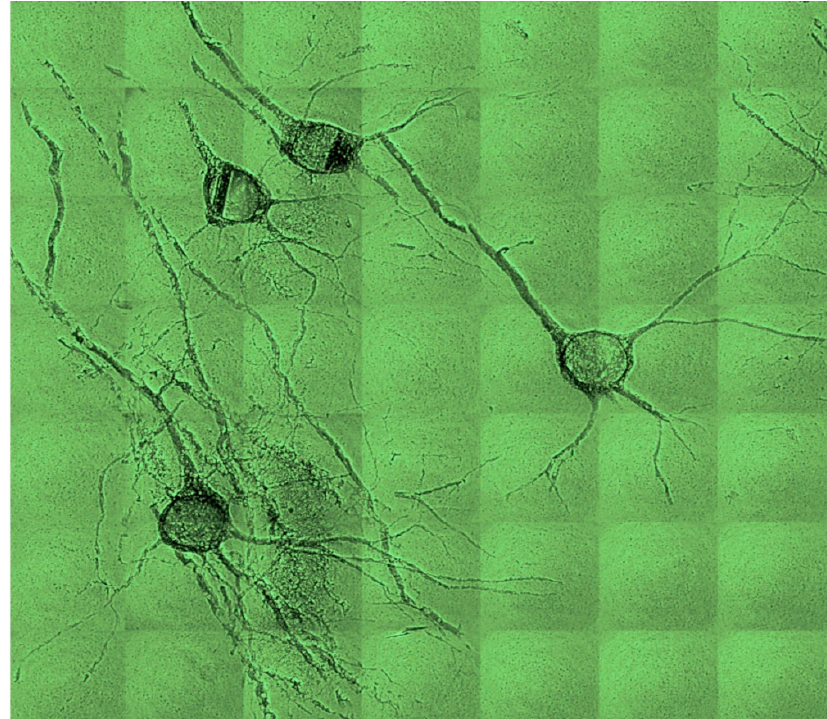
Figure 15. Test of magnification in the X-ray range by a Fresnel zone plate, which demonstrated a lateral resolution sufficient for the analysis of brain specimens at the cellular level [18–24]. Horizontal image size: 130 µm.